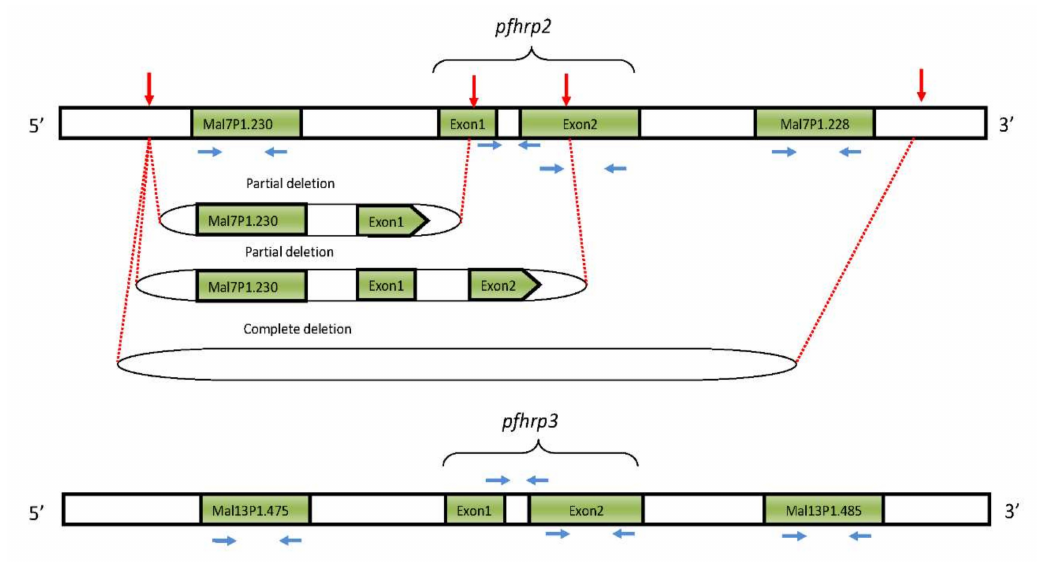
Figure 1. Illustration of pfhrp2 and pfhrp3 genes and their flanking regions (green color), chromosome breakage and rejoining points (in red arrows) and the primer locations for the target genes (blue